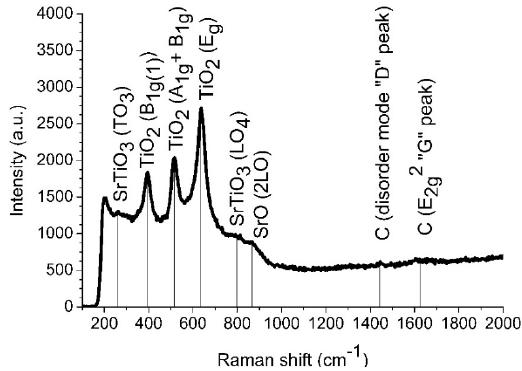
Figure 4. Raman shift spectra of Si/TiO x /Pt/SrTiO 3 /Ni heterostructure.